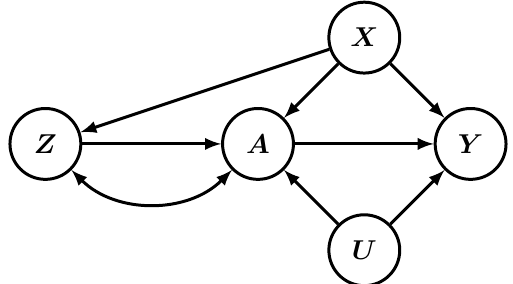
Figure 2. A causal graph with unmeasured confounding. The bi-directed arrow between Z and A indicates the possibility that there may be unmeasured common causes confounding their